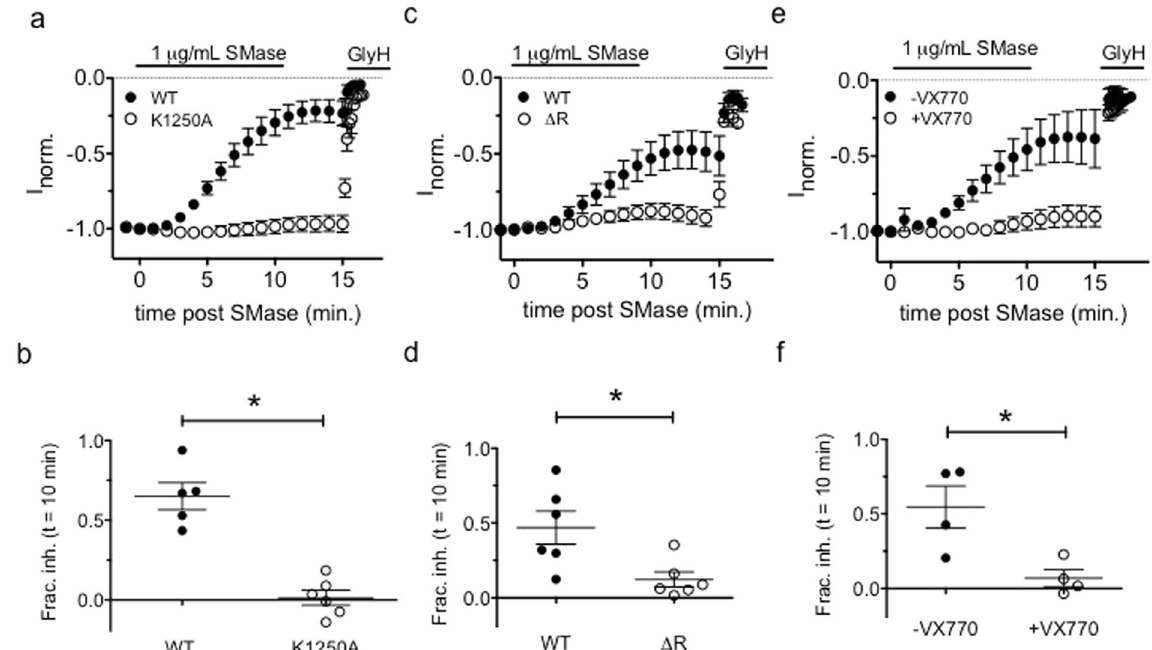
Figure 5. Increased channel activity imparts resistance to SMase-mediated inhibition: ( a , b ) The ATP hydrolysis-deficient K1250A-CFTR mutant was resistant to inhibition by 1 μ g/mL SMase (p < 0.0001, unpaired t-test). ( c , d ) The phosphorylation-independent variant split- Δ R-CFTR was less sensitive to inhibition by SMase than was WT-CFTR in the presence of 0.1 mM IBMX (p = 0.034, unpaired t-test). ( e , f ) Potentiation by VX-770 protected CFTR from inhibition by SMase (p = 0.019, unpaired